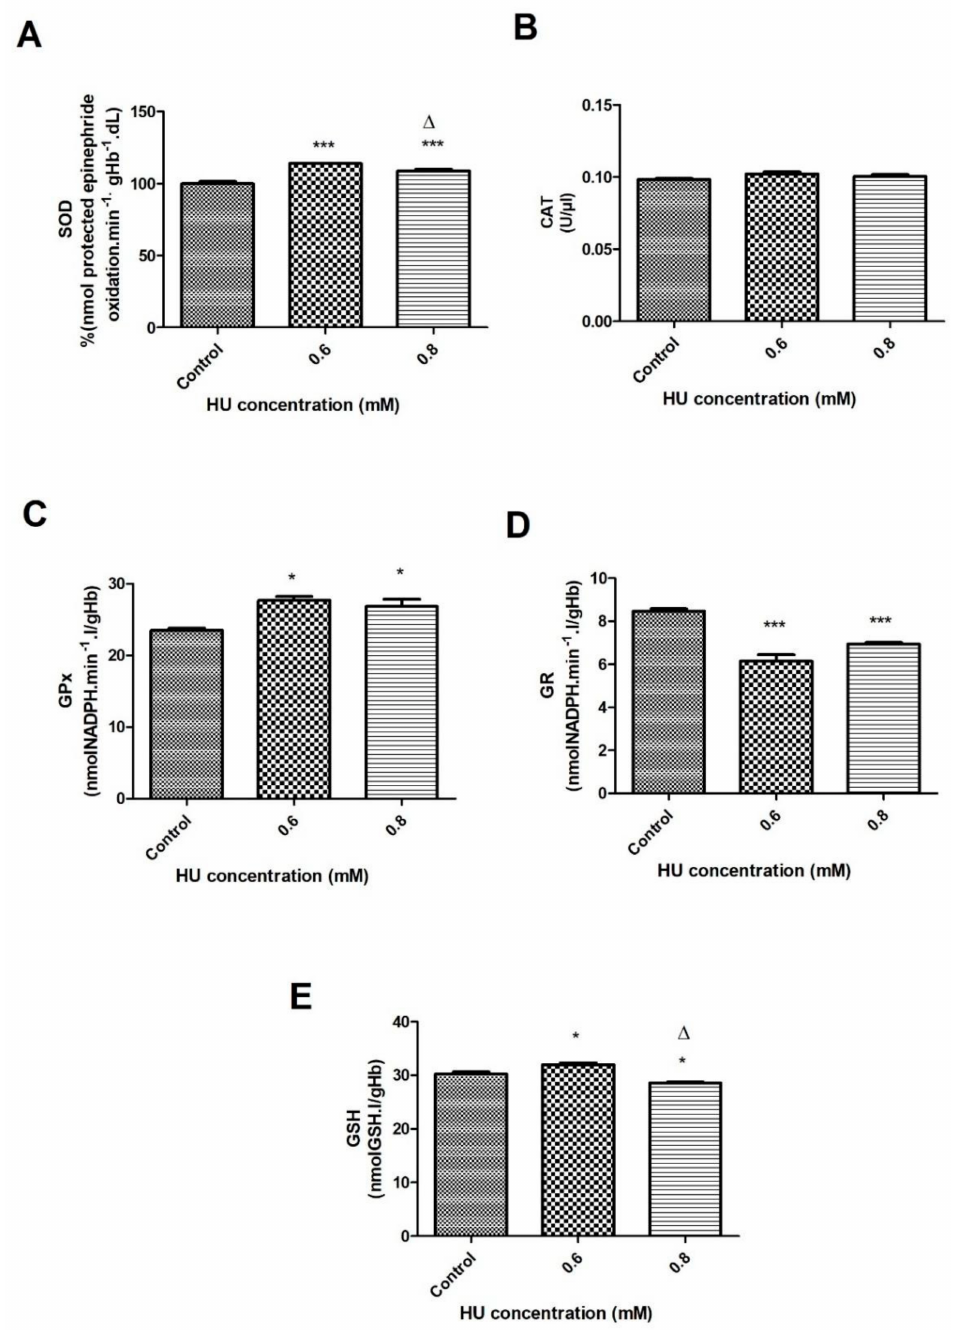
Figure 4. Enzymatic activity of the erythrocyte antioxidant system in the control samples that were treated with 0.6 and 0.8 mM HU (n = 3) for 1 h. Hemolysate was used to measure ( A ) Superoxide dismutase (SOD); ( B ) Catalase (CAT); ( C ) Glutathione peroxidase (GPx); ( D ) Glutathione reductase (GR); ( E ) Reduced glutathione. In all of the cases, * represents a comparison between the controls and the treated groups (* p < 0.05 and *** p < 0.001), while ∆ represents a comparison between the groups that were treated with 0.6 and 0.8 mM HU ( p <